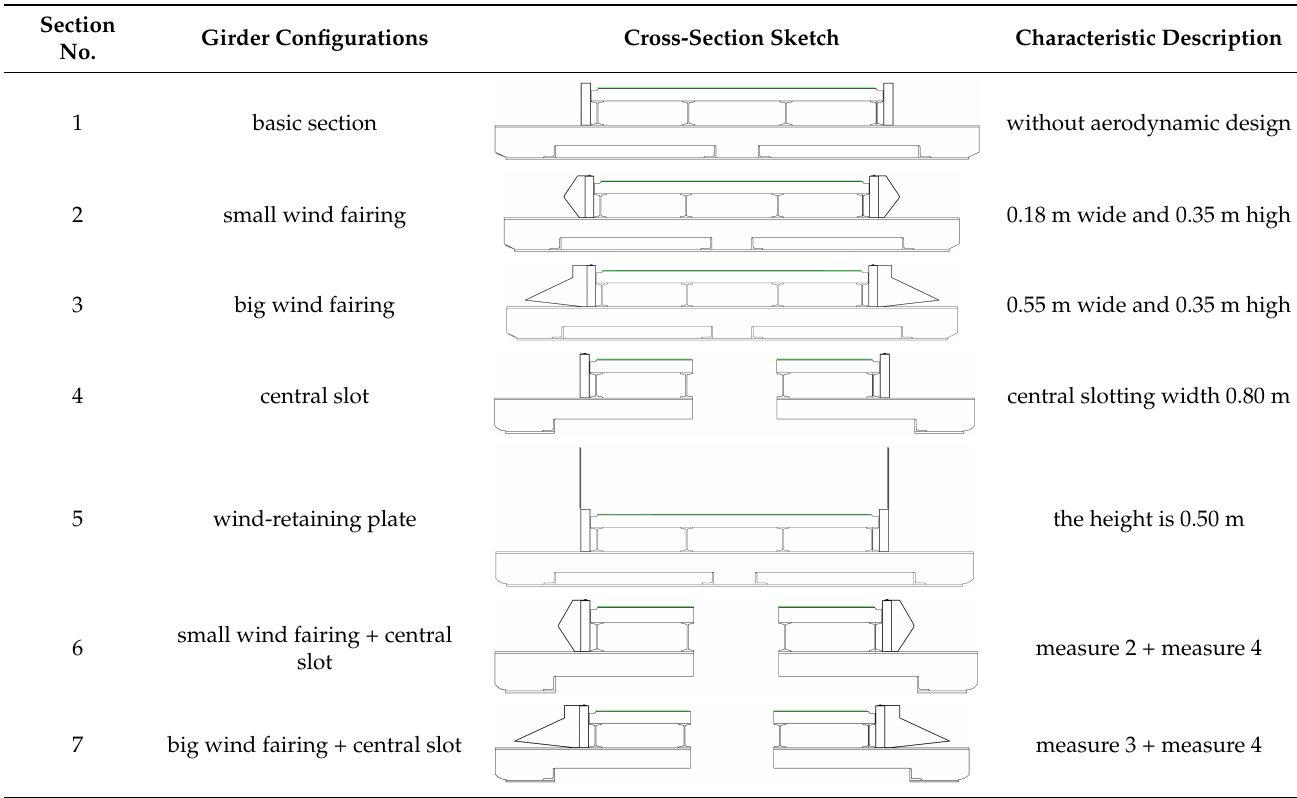
Table 3. General information of seven aerodynamic measures for the girder.